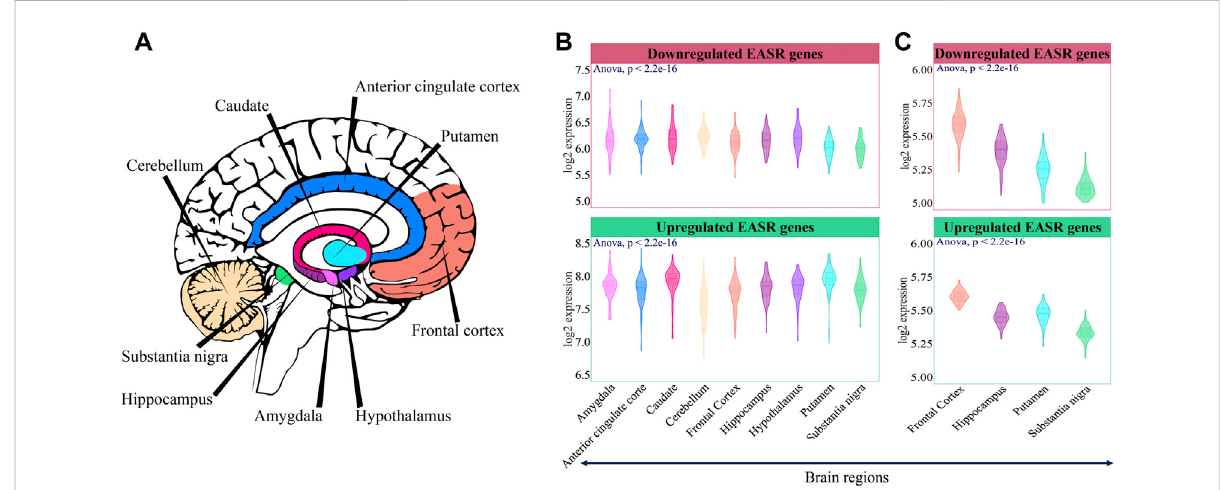
FIGURE 3 Expression pattern of EASR genes in different brain regions. (A) 9 brain regions that were selected for this study. (B) Mean expression of downregulated and upregulated EASR genes in each brain region of the GTEx non-neurological healthy samples (illustrated by colors). The expressionlevel ofbothdownregulatedandupregulatedEASRgenesweresigni fi cantlydifferentacrossGTExbrainregions(ANOVA, p -value < 0.05). (C) Validation across healthy samples in UK Brain Expression Consortium (UKBEC). Downregulated and upregulated EASR gene expression levels were signi fi cantly different across UKBEC brain regions (ANOVA, p -value < 0.05). Putamen was represented the higher expression levels of upregulated EASR genes than substencia nigra in both